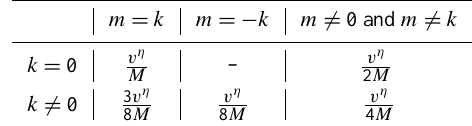
Table 1. Estimated variance of χ k